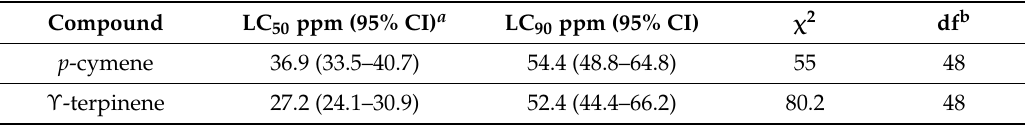
Table 4. Toxicity of pure compounds from S. pilosa chemotypes against 1-d-old larvae of Aedes aegypti at 24 h post